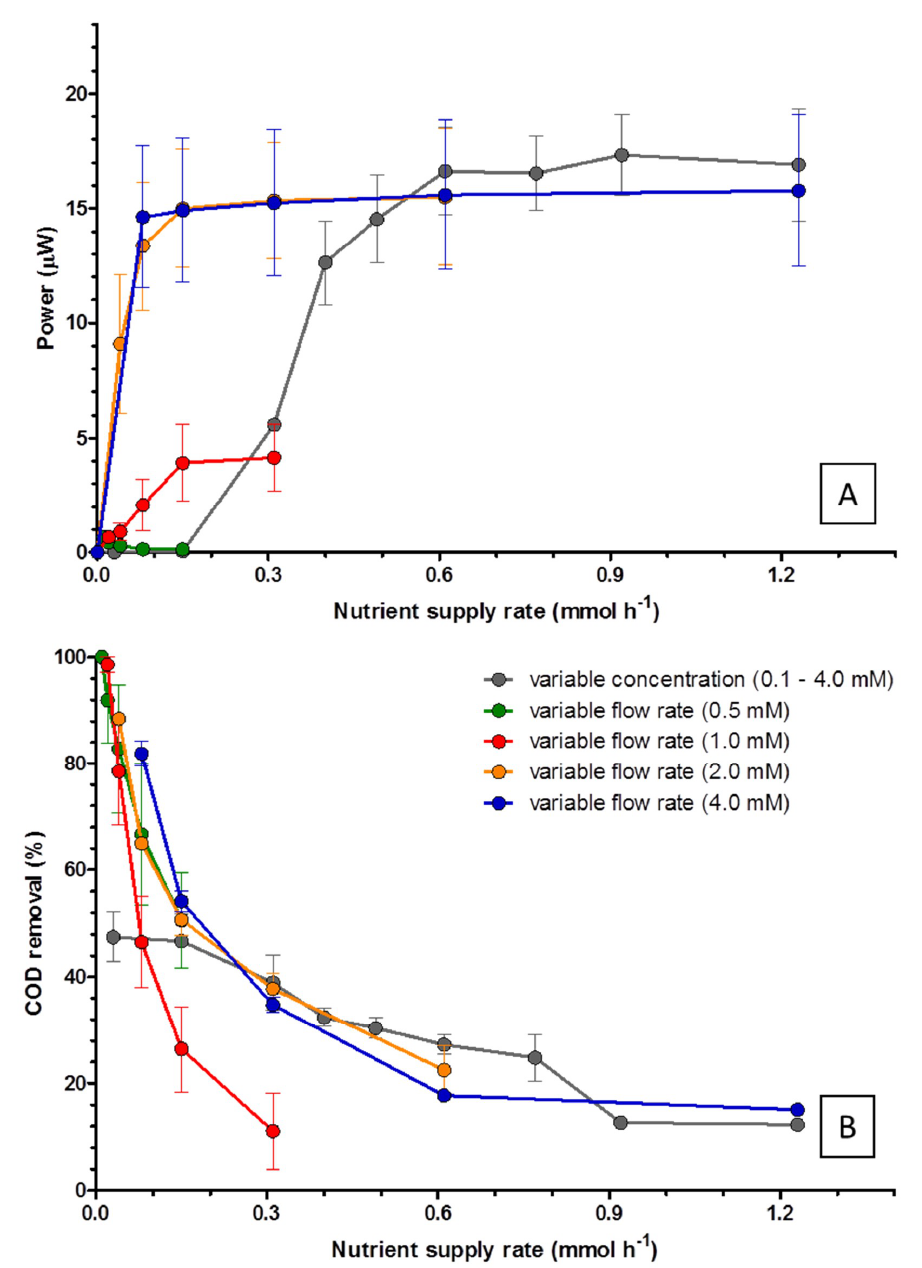
Figure 4. Power output ( A ) and COD removal efficiency ( B ), at different nutrient supply rates.